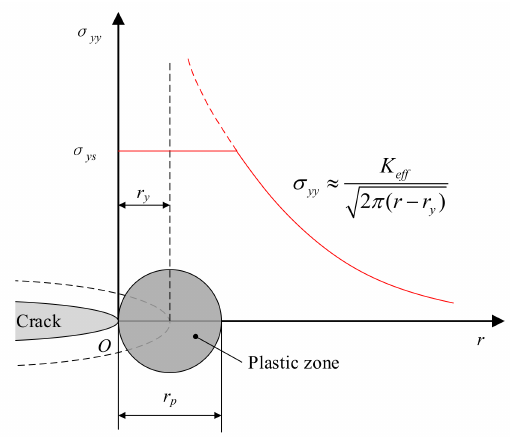
Figure 2. The stress distribution at crack tip of elastic-plastic